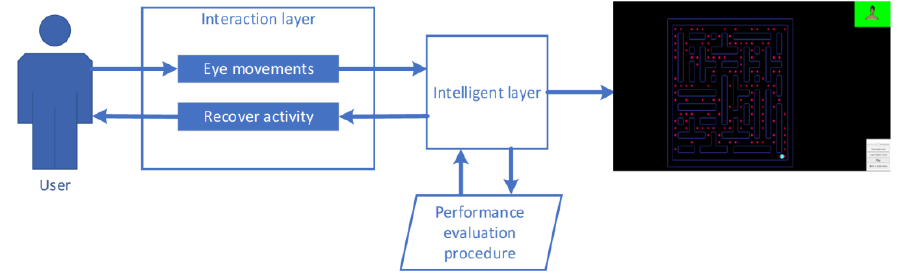
Figure 5. Application of the HASCM model for an eye-controlled game. The HASCM framework for an eye-controlled game is presented in Figure 5. This application of the HASCM consists of the components listed below.